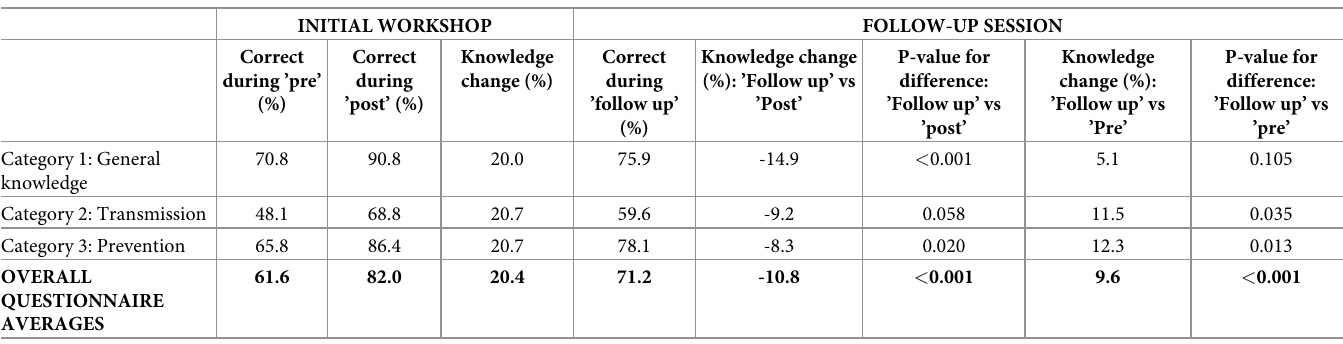
Table 2. Results from ‘pre’, ‘post’ and ‘follow-up’ assessments (QS2). INITIAL